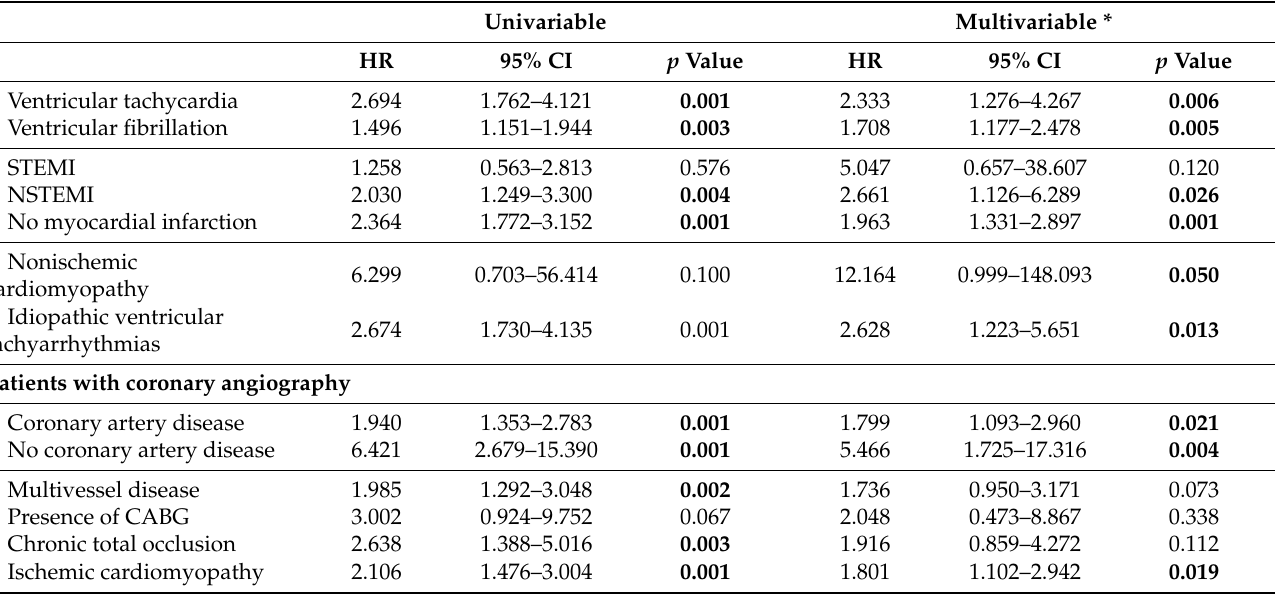
Table 5. Uni- and multivariable hazard ratios for “high cTNI” with regard to 30-day all-cause mortality (primary endpoint) within prespecified